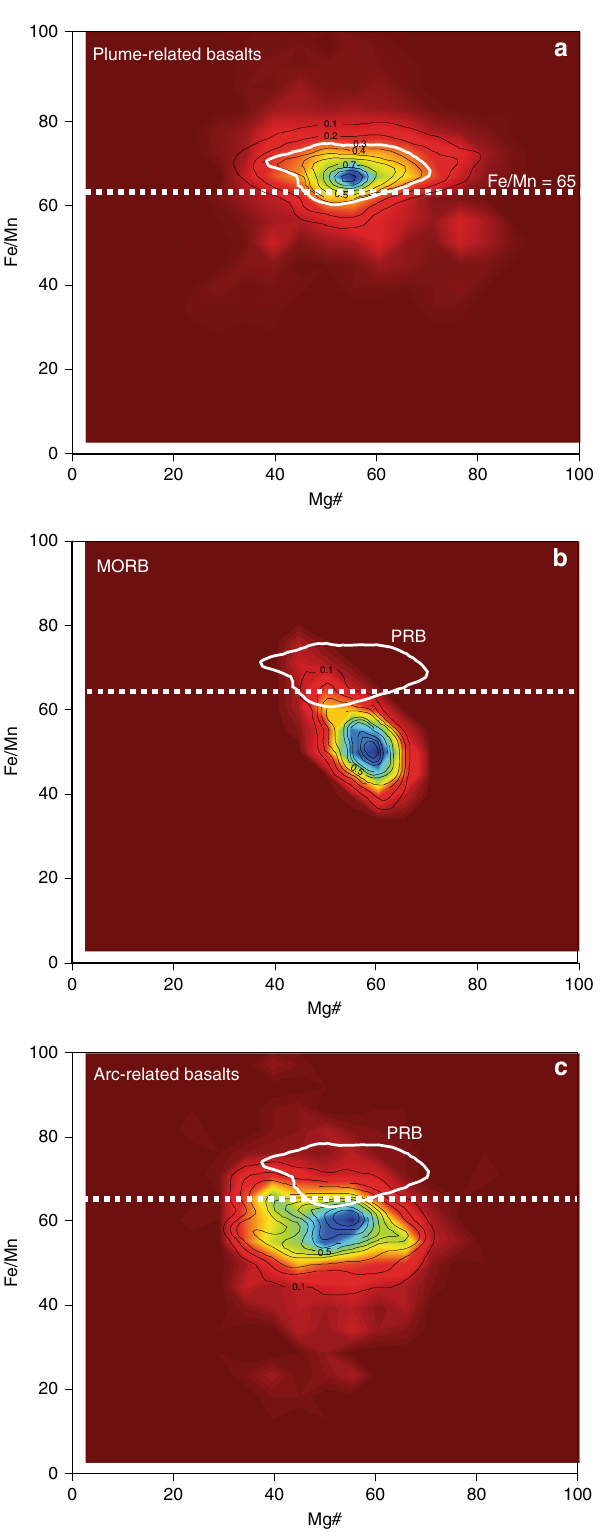
Fig. 2 Density plot of Fe/Mn vs. Mg# for different basaltic types. a Plume-related basalts (PRB); b mid-ocean ridge basalts (MORB); c arc-related basalts. Data sources: Georoc and EarthChem (see Methods). Black contours de fi ne the data density values from high density (blue) to low density (red). The white contour represents 70% of the PRB data